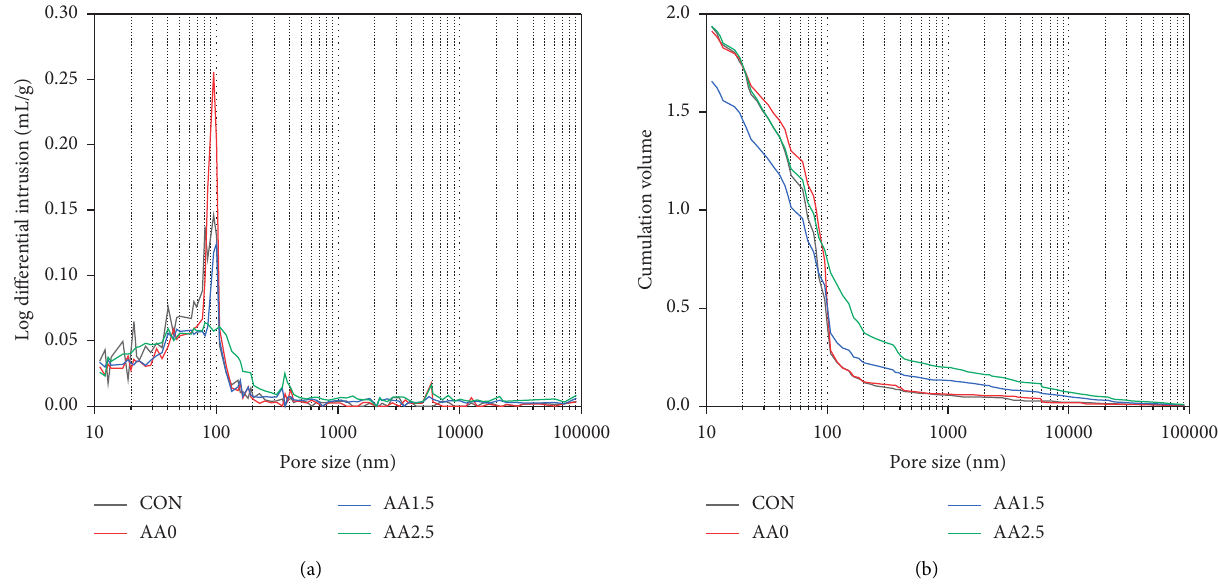
Figure 7: MIP results of the specimen with and without AA/CA. (a) Pore size distribution. (b) Cumulative pore volume.